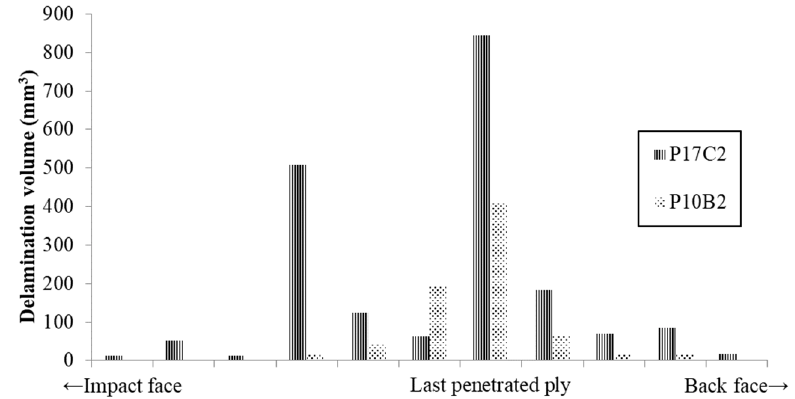
Figure 10. Distribution of delamination volume in each ply throughout panel thickness.